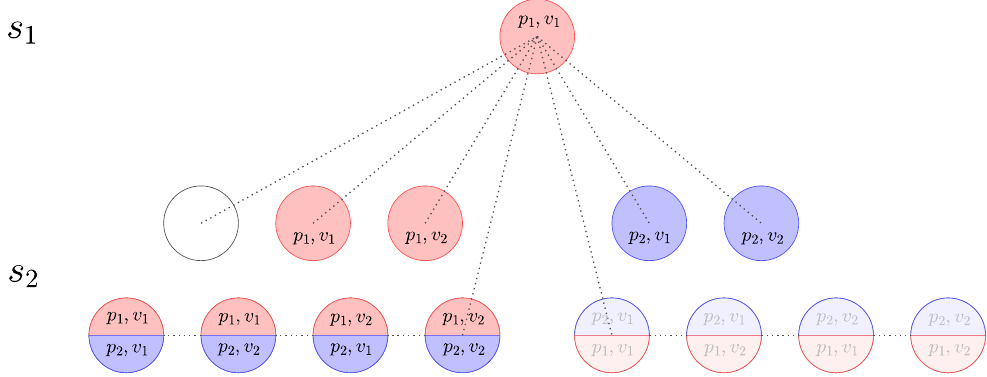
Figure 2. Branching for the pump operation ( n = 2 ) with two speed control options v 1 and v 2 . The colors red, blue and no color represent pumps p 1 and p 2 and no pump. Faded nodes represent